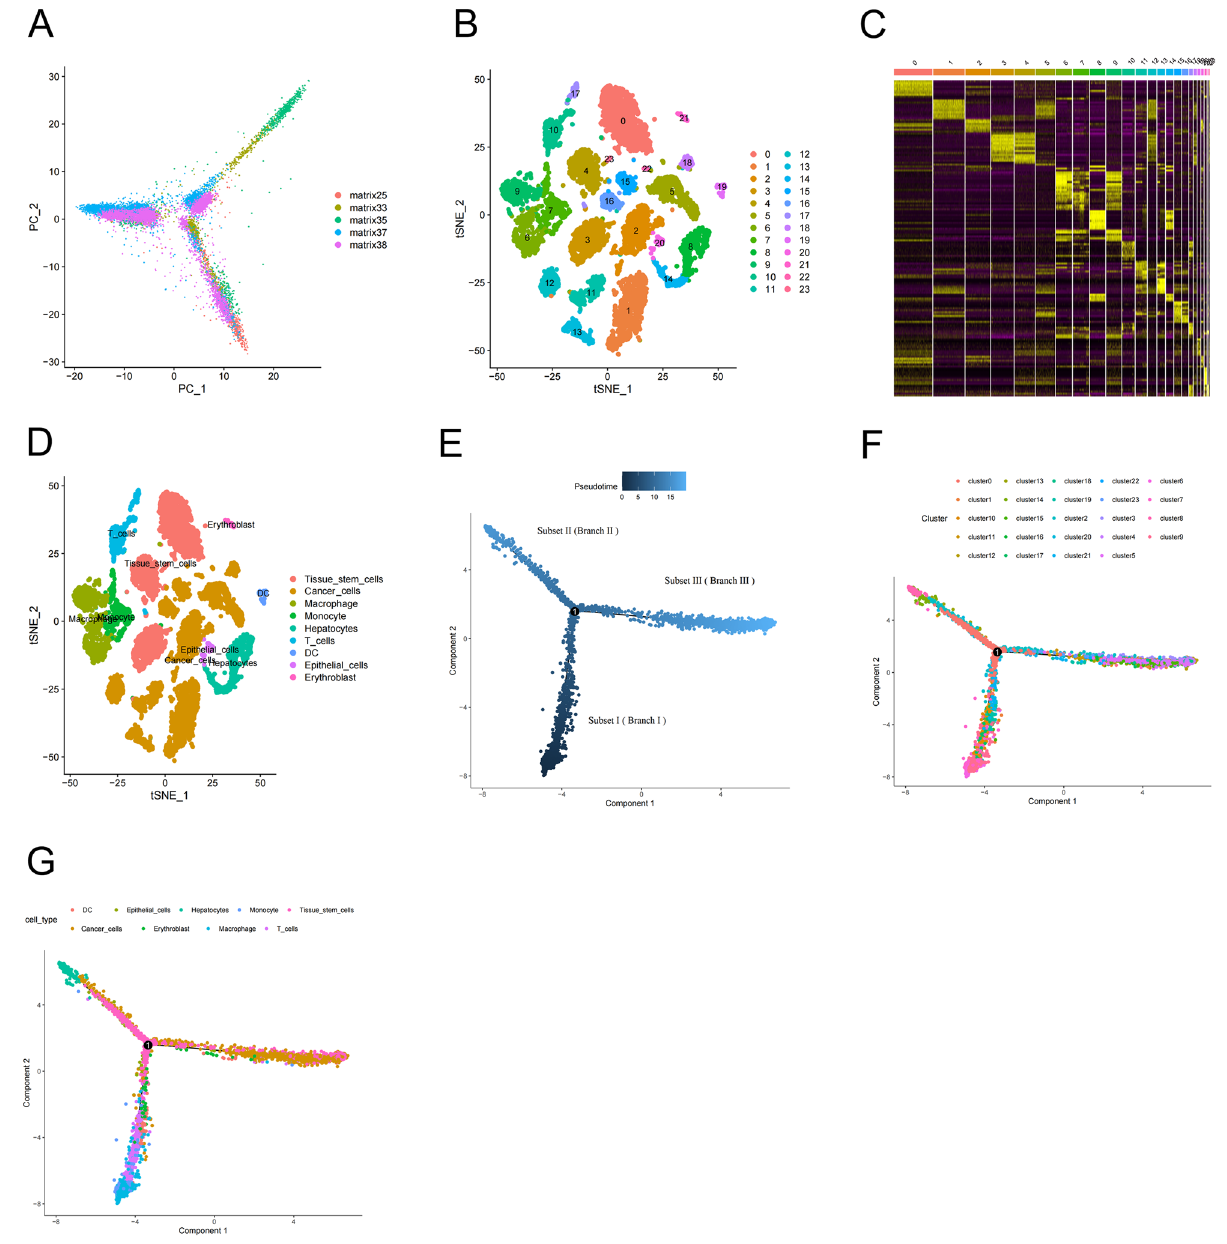
Figure 2. Identification of ccRCC subsets by the single-cell trajectory analysis. ( A ) PCA of scRNA-seq data for preliminary dimensionality reduction. ( B ) tSNE was used for clustering of ccRCC cells. ( C ) Heatmap of marker genes in each cluster. Yellow represents upregulated genes and purple indicates downregulated genes. ( D ) Cell- type annotation of clusters. 24 clusters were divided into 9 cell types according to marker genes. ( E ) Single-cell pseudotime analysis of three subsets. Dark blue denotes an earlier time. ( F, G ) Trajectory analysis of clusters and cell types. The dots of different colors represented the corresponding clusters or cell types, which were arranged on the pseudotime